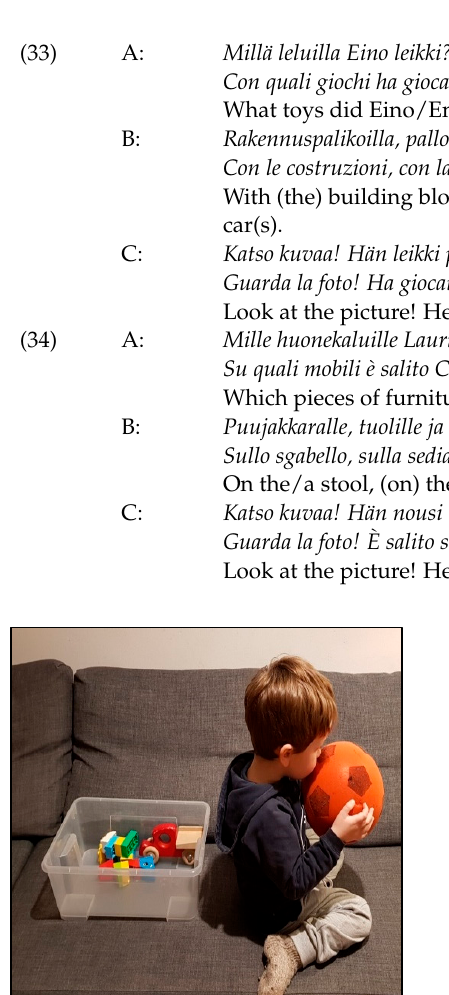
Table 1. Experimental conditions .